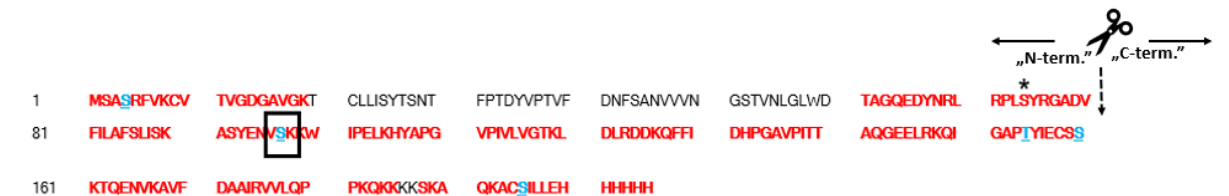
Figure 5. Phosphorylation of Arabidopsis ROP1 by CPK17. CPK17-dependent in vitro phosphorylated sites of AtROP1 as determined by mass spectrometry (MS). The detected sequence is shown in red. Phosphorylated residues in the identified peptides are in blue. The non-phosphorylated S74 residue is indicated by *. The S97 residue represented by most of the phosphopeptides (Table S1) is boxed. The scissors symbol indicates where the sequence was dissected to separately express N- and C-terminal regions, respectively.